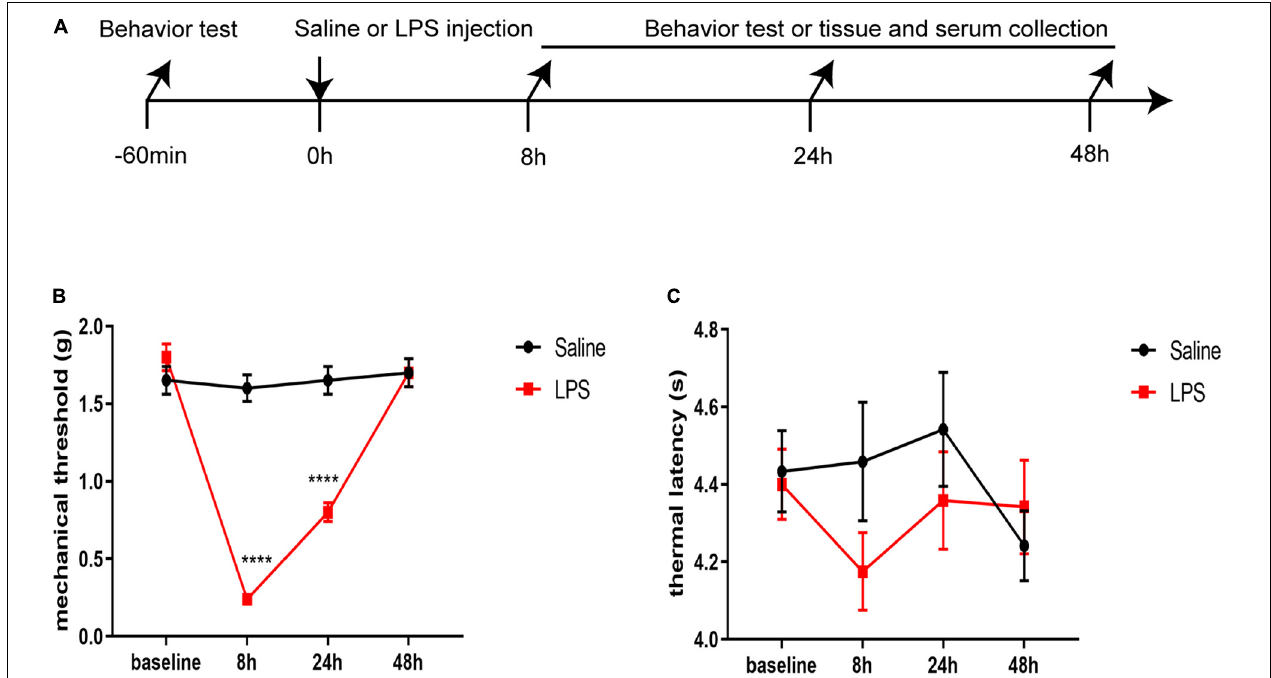
FIGURE 1 | Lipopolysaccharide (LPS) induced acute mechanical hyperalgesia but not thermal hyperalgesia. (A) Experimental design. P5-6 rat pups were intraperitoneally injected with saline or LPS. Baseline mechanical threshold and thermal latency were measured 1 h before saline or LPS injection. Eight, 24, and 48 h after injection, rat pups underwent a nociceptive behavior test or were sacrificed for messenger ribonucleic acid (mRNA) analyses, ELISA, and immunofluorescence. (B) Rats in the LPS group showed decreased mechanical threshold 8 and 24 h after LPS injection. (C) No significant difference was found in thermal latency between the rats in the LPS group and the rats in the Saline group at each time point. The results are expressed as the mean ± standard error of the mean (SEM), n = 12 animals for each group and were analyzed by two-way repeated-measures analysis of variance (ANOVA) followed by Bonferroni’s multiple comparisons test. **** P < 0.0001 LPS group vs. Saline group.